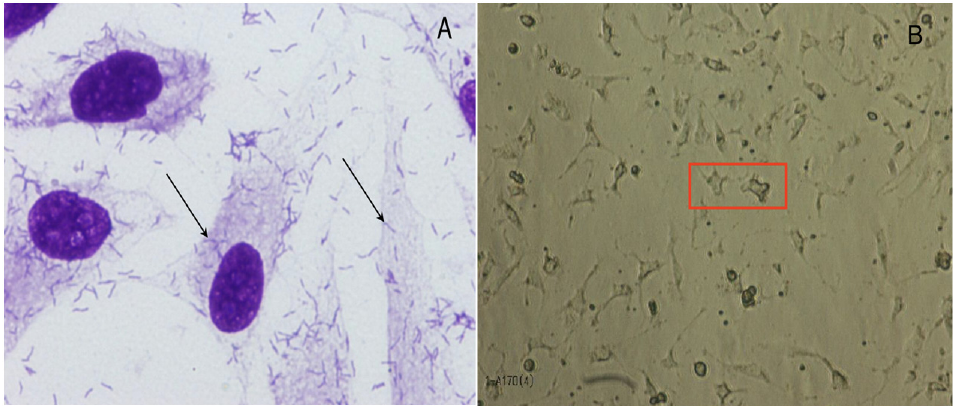
Figure 1. ( A ) Adherence of Arcobacter butzleri to HeLa cells. ( B ) VERO cells after the addition of A. butzleri supernatant, presenting elongated cells with rounded vacuoles (Red box). All strains were positive in the toxicity tests, with observable effects in the form of vacuolation and destruction of Vero cells (Figure